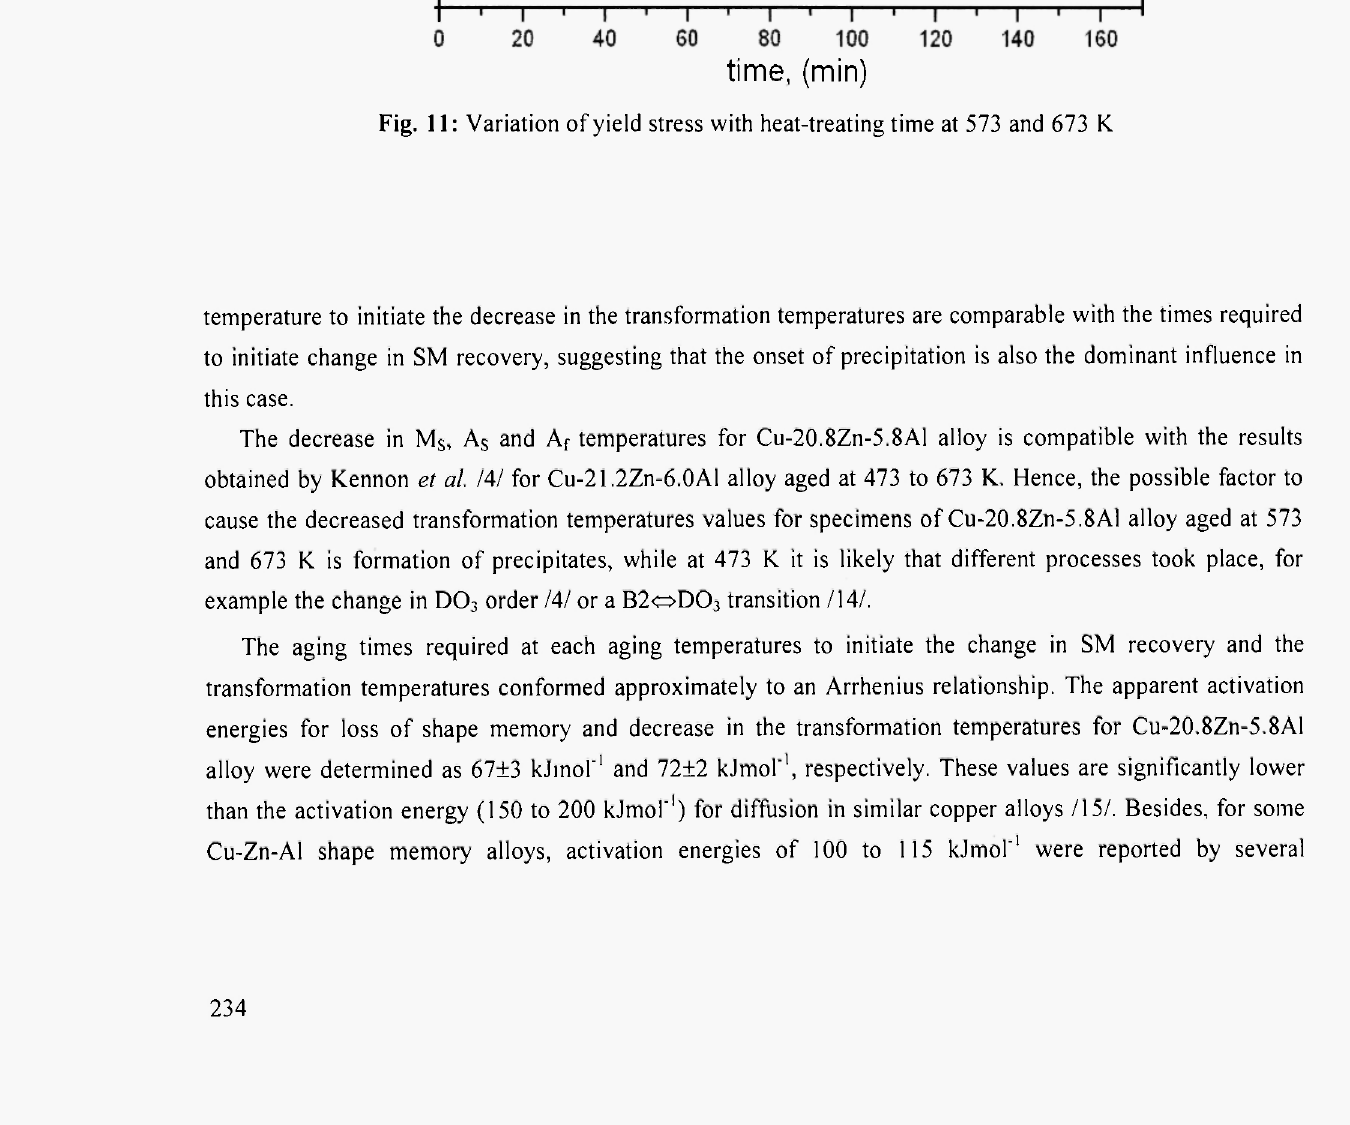
Fig. 11: Variation of yield stress with heat-treating time at 573 and 673